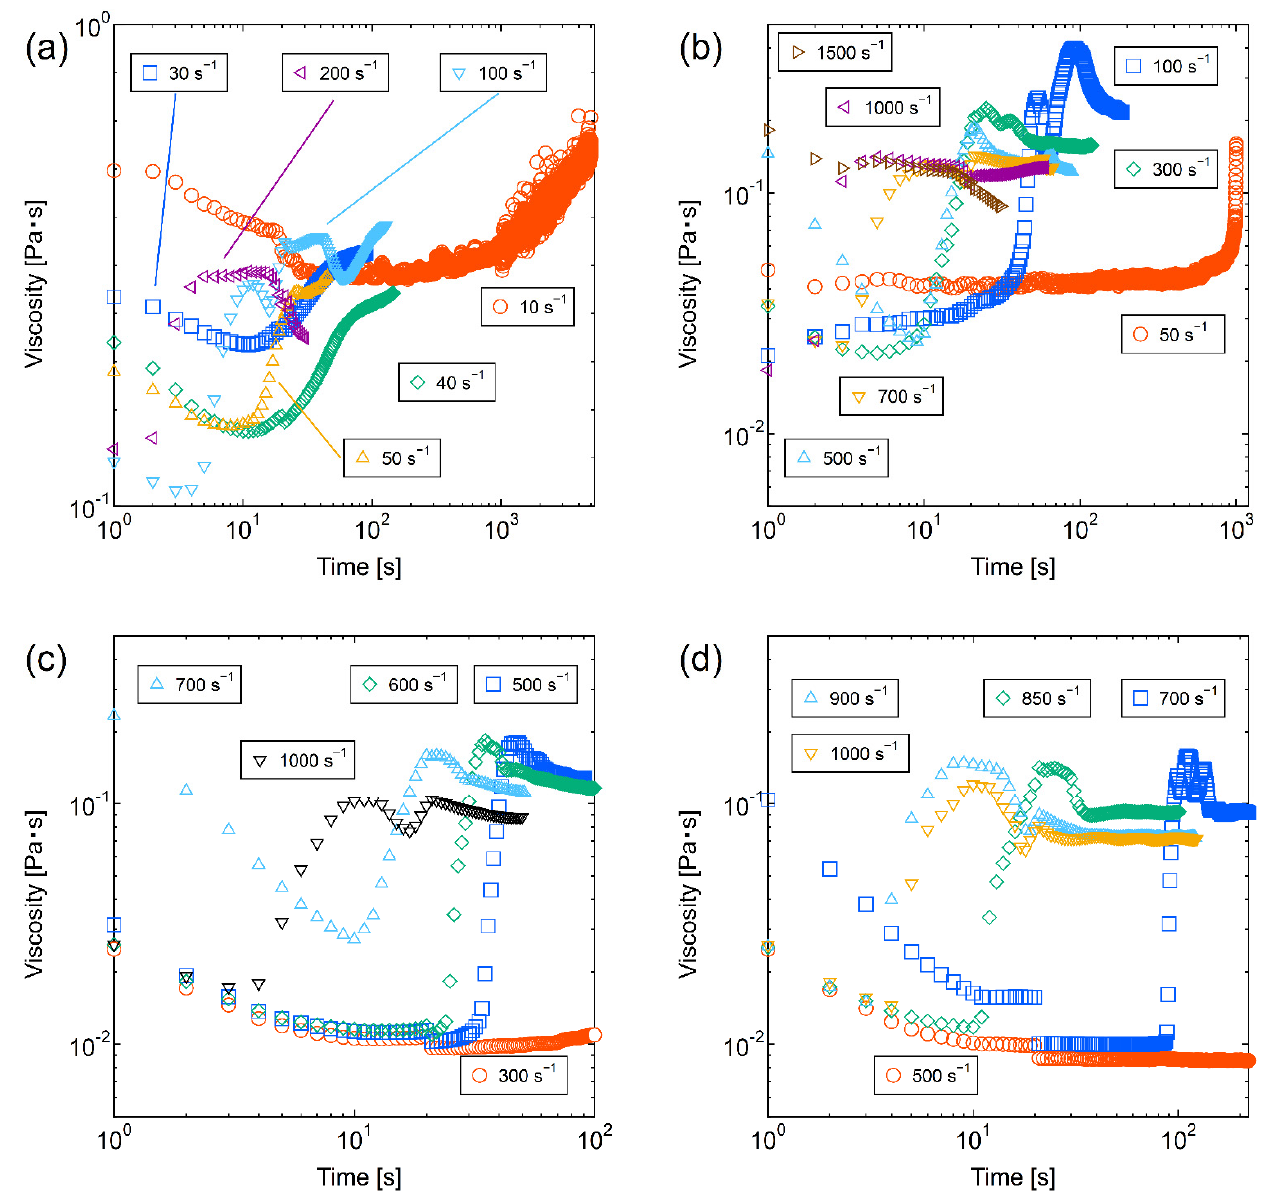
Figure 3. Temporal changes in viscosity of shake-gels under steady shear rates. The C p values (the amount of polymer dose per silica surface area) were ( a ) 0.03 mg/m 2 , ( b ) 0.05 mg/m 2 , ( c ) 0.08 mg/m 2 , and ( d ) 0.15 mg/m 2 , respectively. The PEO’s molecular weight was 1000 kg/mol.